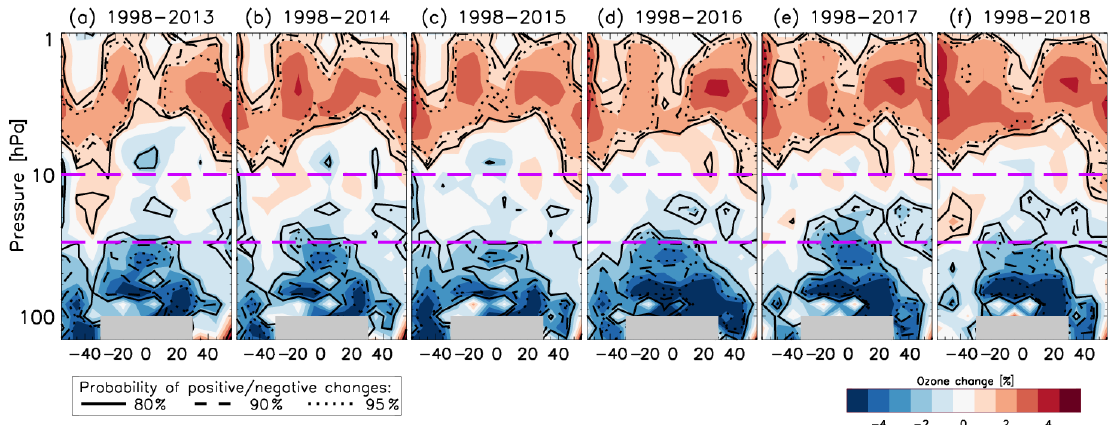
Figure 1. Zonally averaged ozone changes between 1998 and the end years from (a) 2013 to (f) 2018. Red represents increases, and blue denotes decreases (%; see right-hand legend). Contours represent probability levels of positive or negative changes (see left-hand legend). Grey shaded regions represent unavailable data. Magenta dashed lines delimit regions integrated to partial ozone columns in other